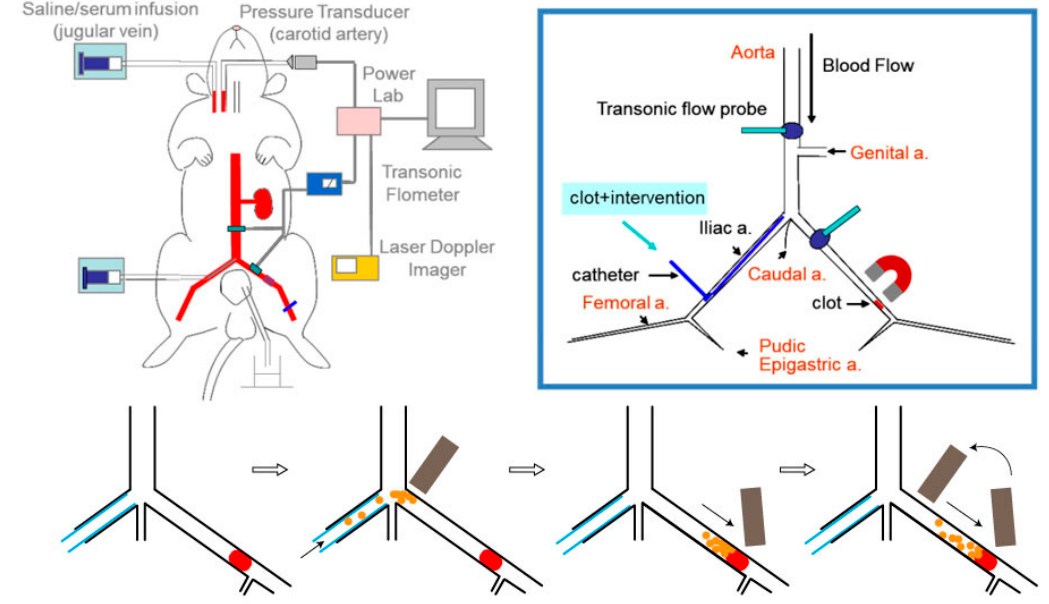
Figure 3. Schematic diagram of the rat iliac thromboembolic model and the magnetic guiding strategy. A preformed clot may be introduced from the right iliac cannula and lodged in the left iliac artery; FeCl 3 -induced thrombosis can be triggered in the left iliac artery. A mobile magnetic guiding strategy has been demonstrated crucial to achieve thrombolytic efficacy of rtPA nanocomposites administered from the right iliac artery ( modified from [24]).